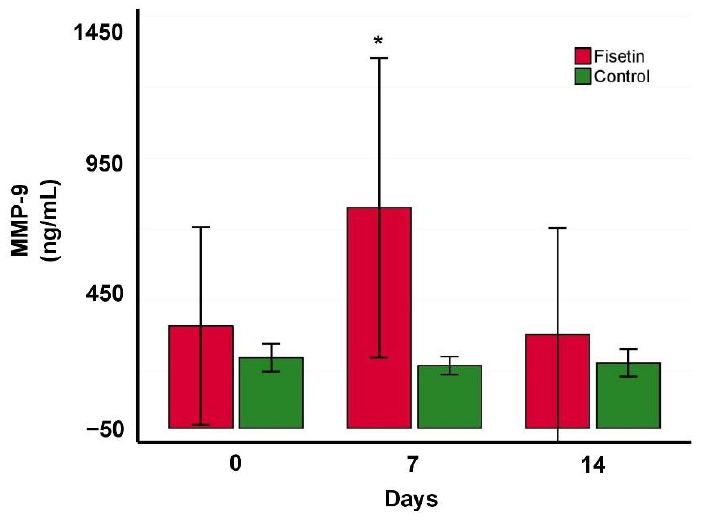
Figure 4. Mean change in tear film MMP-9 levels over the treatment period in fisetin (red) and con- trol (green) groups. Statistical significance was tested using an unpaired two-sided t -test, * p <0.05.